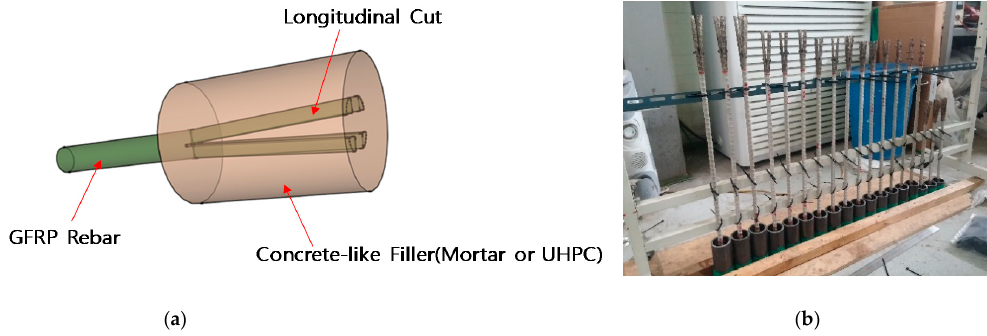
Figure 4. Newly developed concrete headed GFRP rebar. ( a ) Conceptual diagram. ( b ) Photograph of concrete headed GFRP rebar.